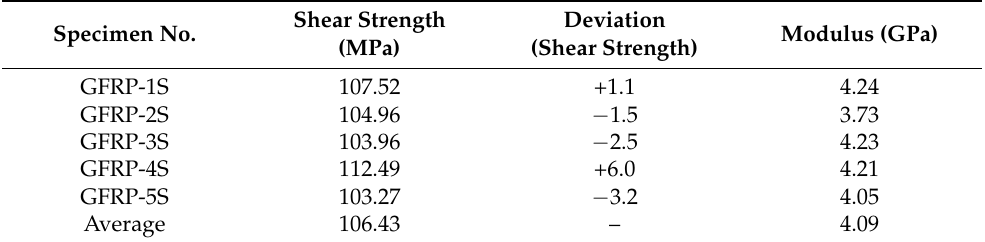
Table 4. Mechanical properties of shear specimen.